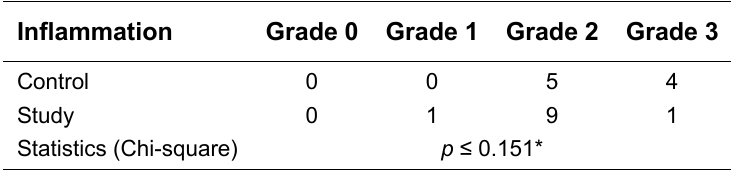
Inflammation Grades of the Study and Control Group